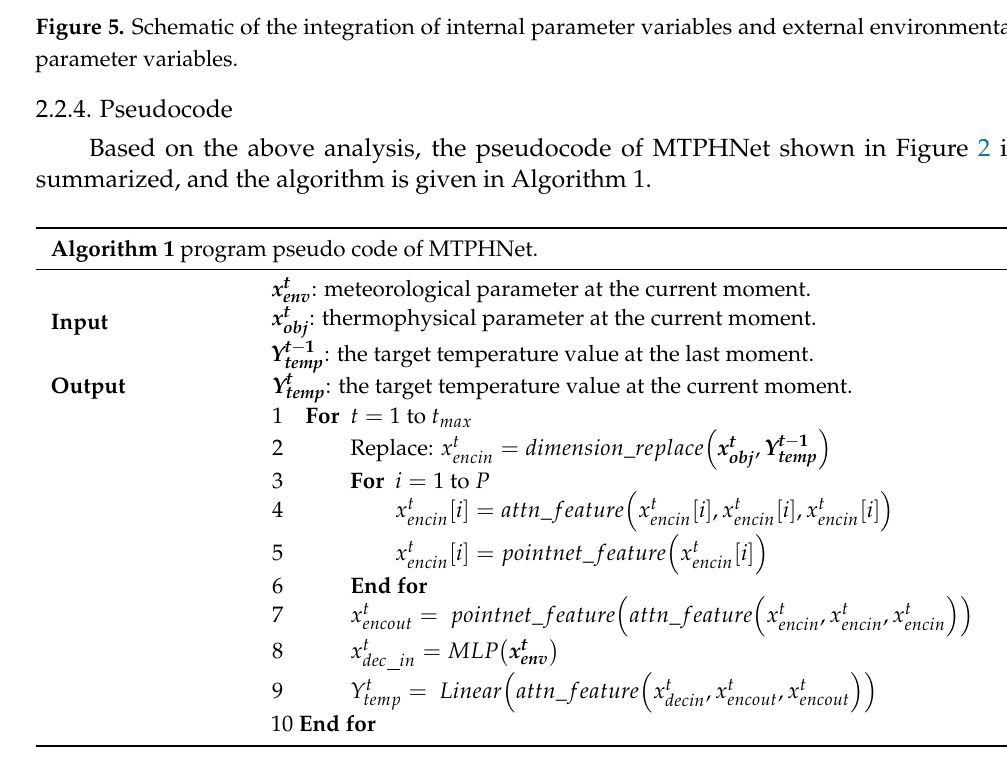
Figure 5. Schematic of the integration of internal parameter variables and external environmental parameter variables.